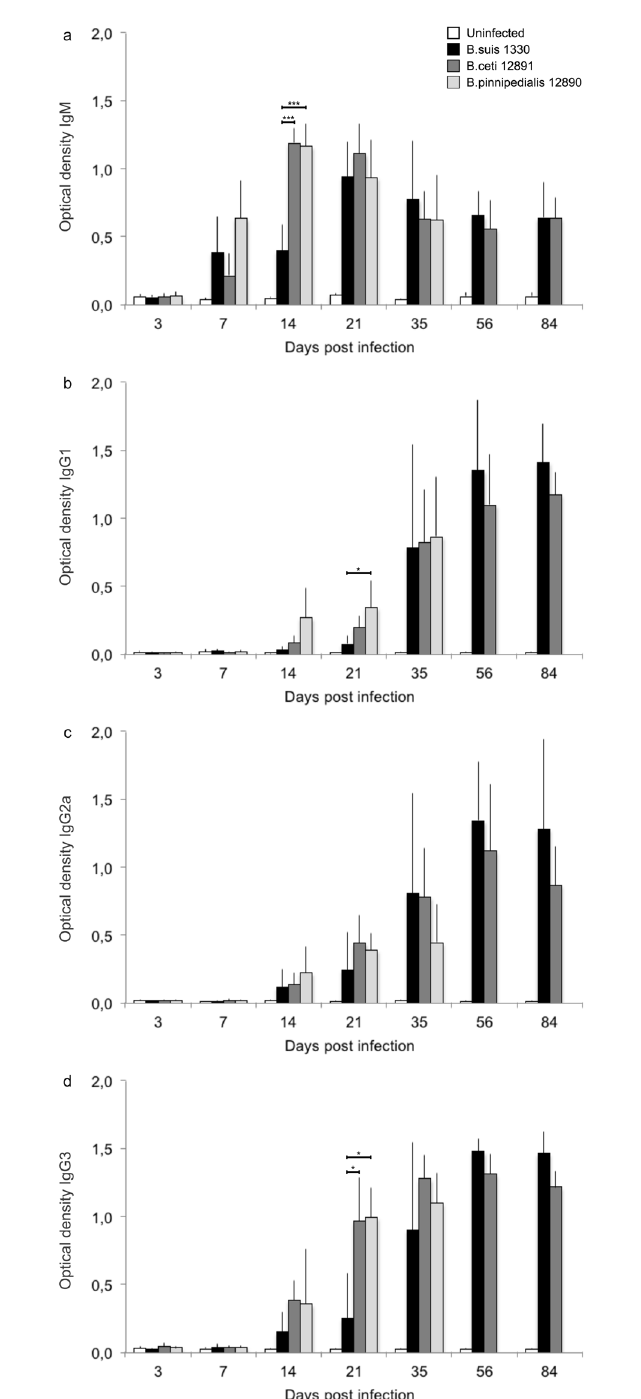
Fig 2. Serum antibody isotypes. Serum antibody isotype patterns for immunoglobulin (Ig) M (a), IgG1 (b), IgG2a (c) and IgG3 (d) in BALB/c mice after intraperitoneal (ip) inoculation of 10 5 colony forming units (CFU) of B . suis 1330 (black), B. pinnipedialis 12890 (light grey), B . ceti 12891 (dark grey) or B . pinnipedialis 12890 (light grey). Uninfected mice received sterile phosphate buffered saline ip (white). Four or five mice were euthanized per lot at day 3, 7, 14, 21, 35, 56 and 84 post infection (day 56 and 84; only B . ceti 12891 and B . suis 1330). Data are presented as mean optical density + one standard deviation. The marine mammal reference strains were compared to B . suis 1330 and *** = p < 0.001, ** = p < 0.01, * = p < 0.05.